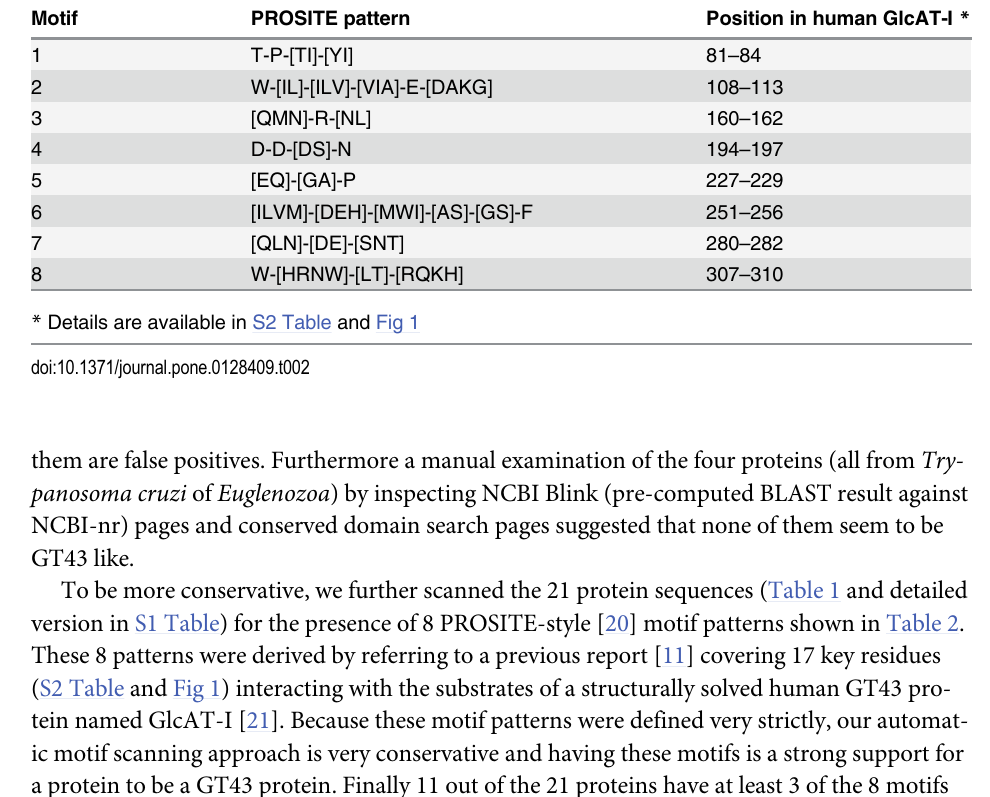
Table 2. PROSITE [20] style patterns of 8 conserved sequence motifs found in GT43